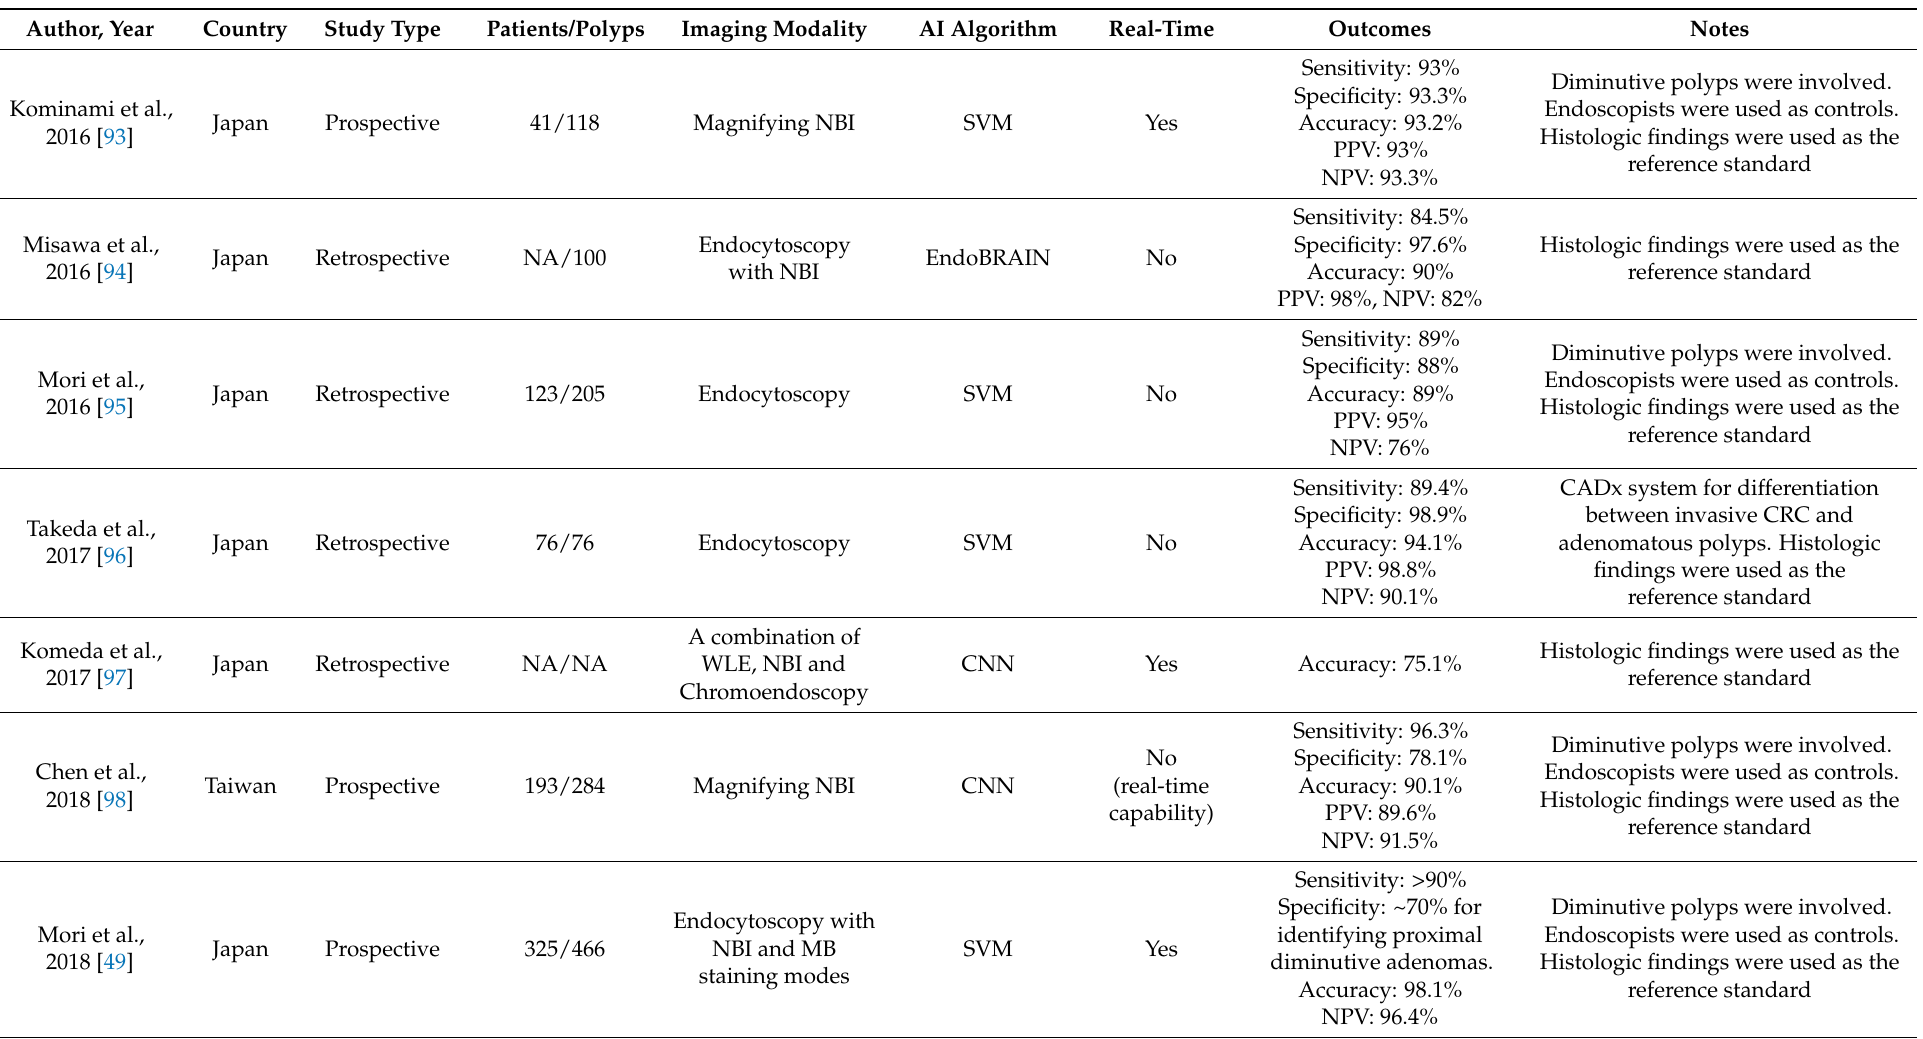
Table 2. Summary of recent studies on AI systems for colorectal polyp